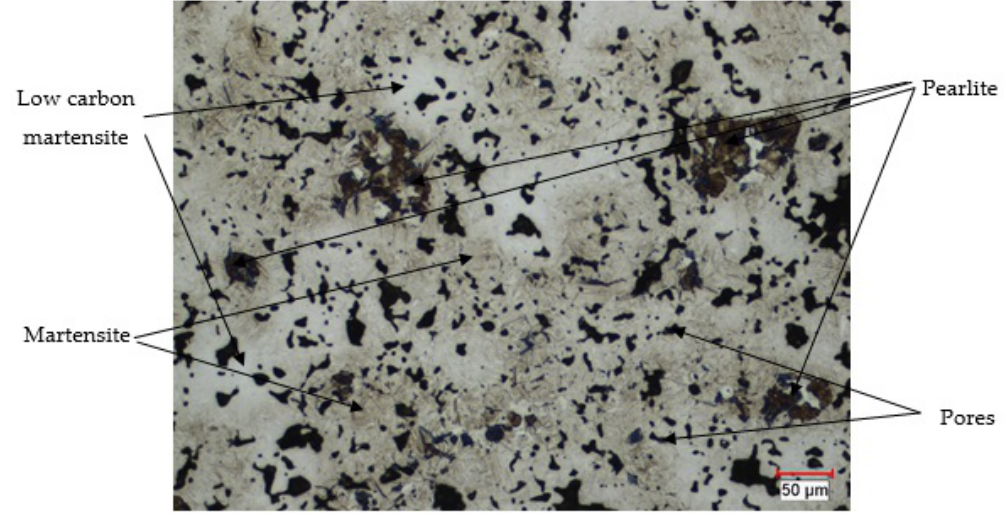
Figure 12. Optical image for sintered and heat treated bar, in the core region, prepared using powder mixture A’ using magnification 200×.